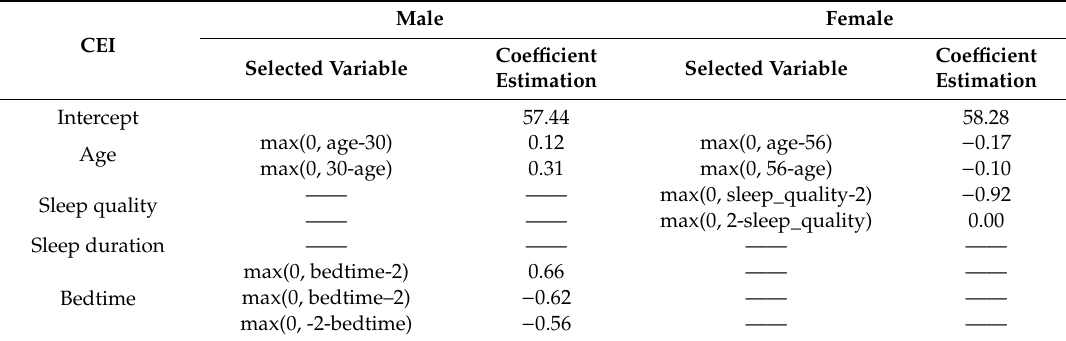
Table 7. Estimation results for CEI by